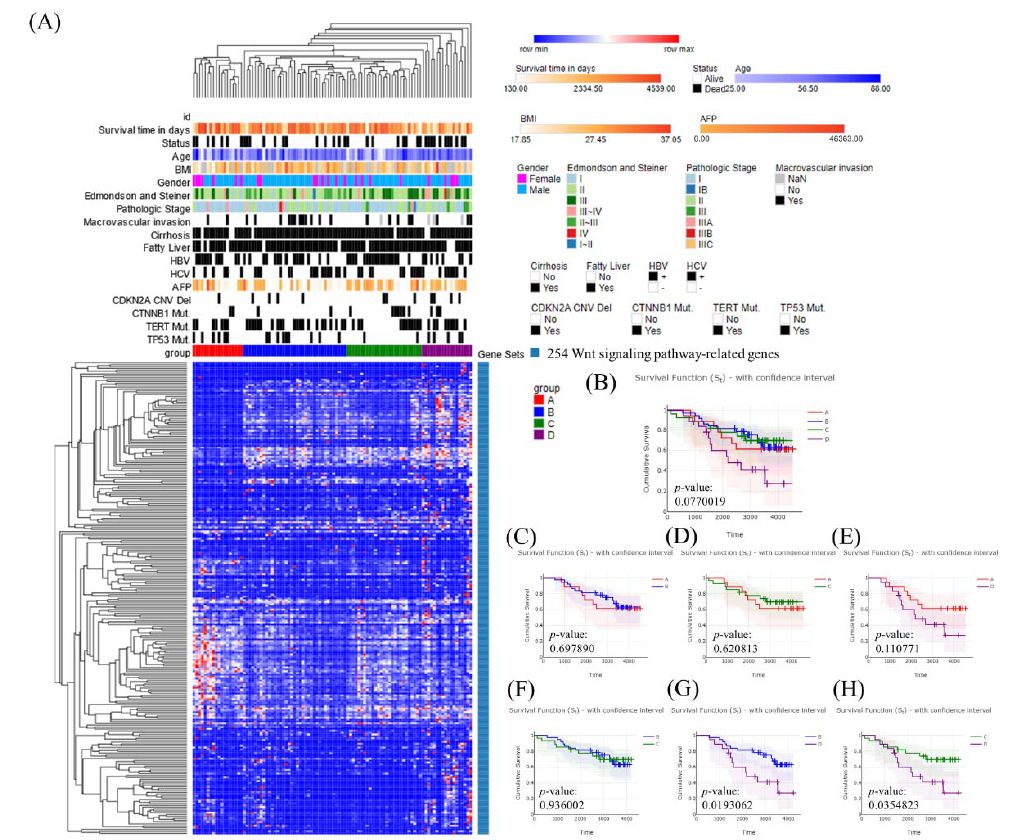
Figure 1. Molecular classification of Taiwanese hepatocellular carcinoma (HCC) using a panel of 254 Wnt pathway genes. ( A ) Heatmap showing normalized expression levels of 254 signature genes (rows) across subjects (columns) divided into four molecular subclasses ( A – D ) using an unsupervised approach. Each signature gene was significantly up ‐ or downregulated in one subclass relative to the other subclasses, as indicated by color changes, where blue and red indicate low and high expression, respectively. Signature genes and subjects were hierarchically clustered within each subclass. Significant differences in demographic characteristics, clinical annotations, molecular subclasses, and hepatitis B and C virus infection status across subjects are shown at the top of the figure. ( B – H ) Overall survival of subjects in each molecular subclass.